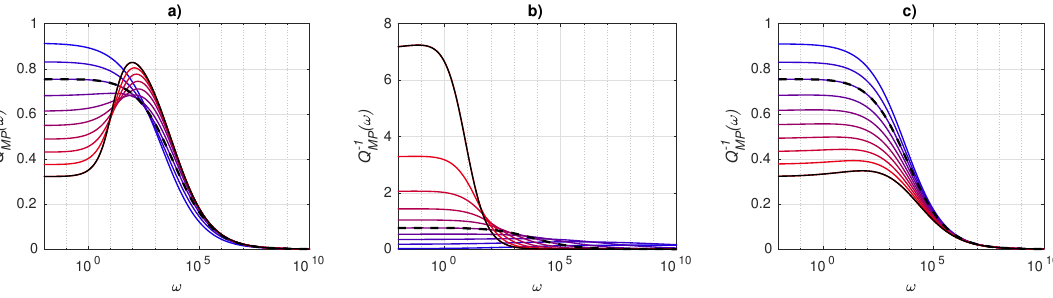
Figure 1. Q -factor of the Maxwell–Prabhakar model for a = 0.01, Ω = − 10. Model dependence on α = 0.1,0.2,. . .,1, β = 0.5, γ = 0.3 ( a ); model dependence on β = 0.1,0.2,. . .,1, α = 0.3, γ = 0.3 ( b ); model dependence on γ = 0.1,0.2,. . .,1, β = 0.5, α = 0.3 ( c ). Parameter value increasing from blue to red. In all panels the dashed line corresponds to α = 0.3, β = 0.5, γ = 0.3.